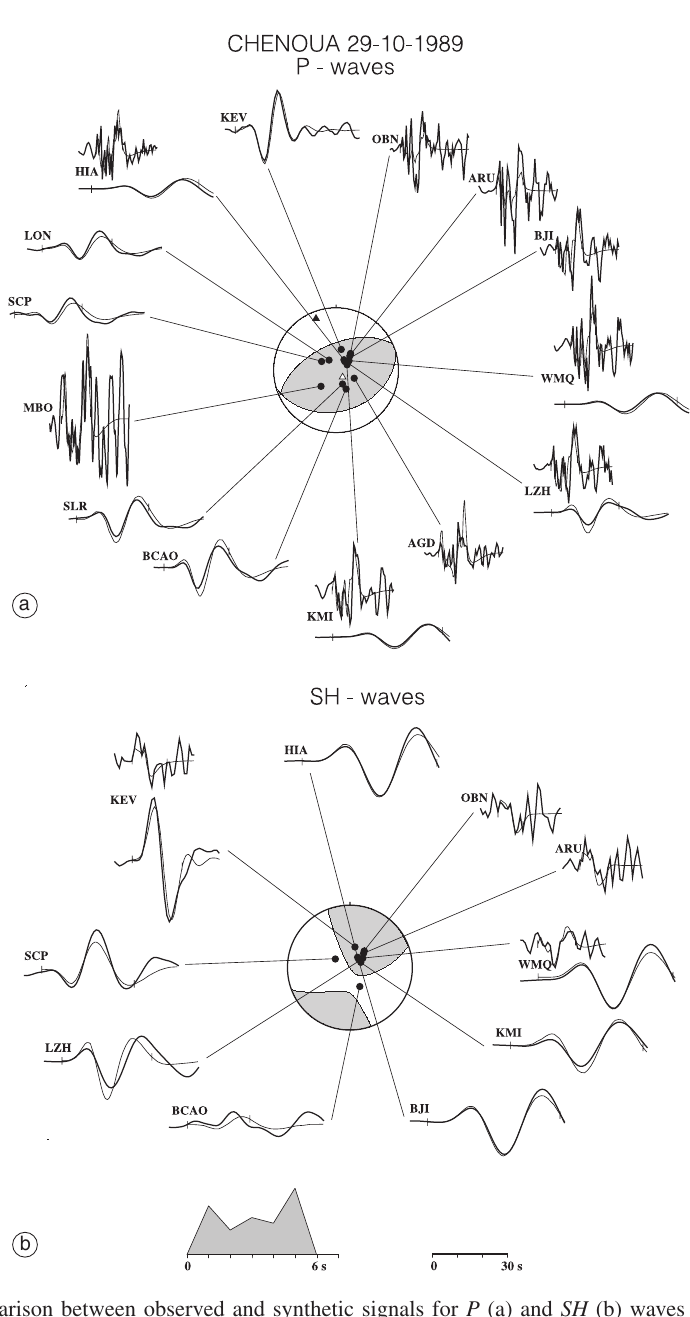
Fig. 2a,b. Comparison between observed and synthetic signals for P (a) and SH (b) waves for a single point source inversion (step I). Thick lines: observed signal; thin lines: synthetic signal. Solid and open triangles: P and T axes,